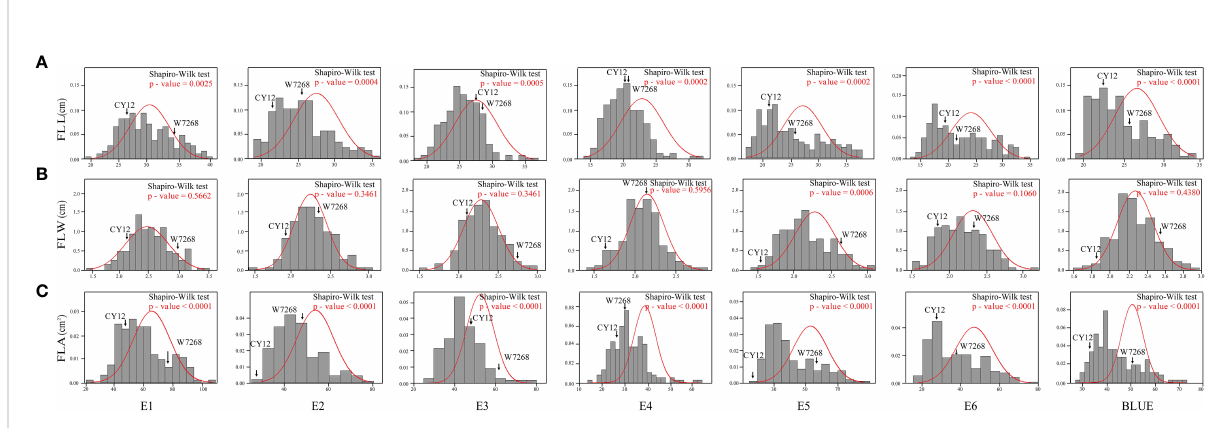
FIGURE 2 Frequency distribution of the WC12 lines for fl ag leaf length (FLL) (A) , fl ag leaf width (FLW) (B) , and fl ag leaf area (FLA) (C) in six environments and the BLUE datasets.